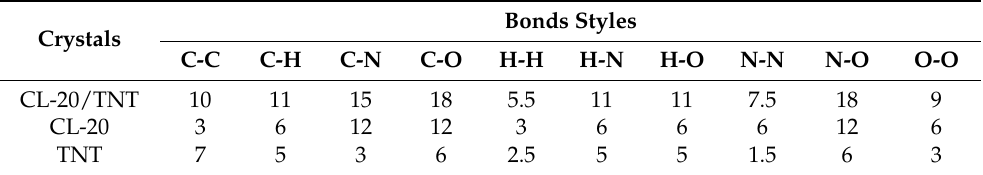
Table 3. Numbers of the most generated chemical bonds in CL-20/TNT, CL-20 and TNT.